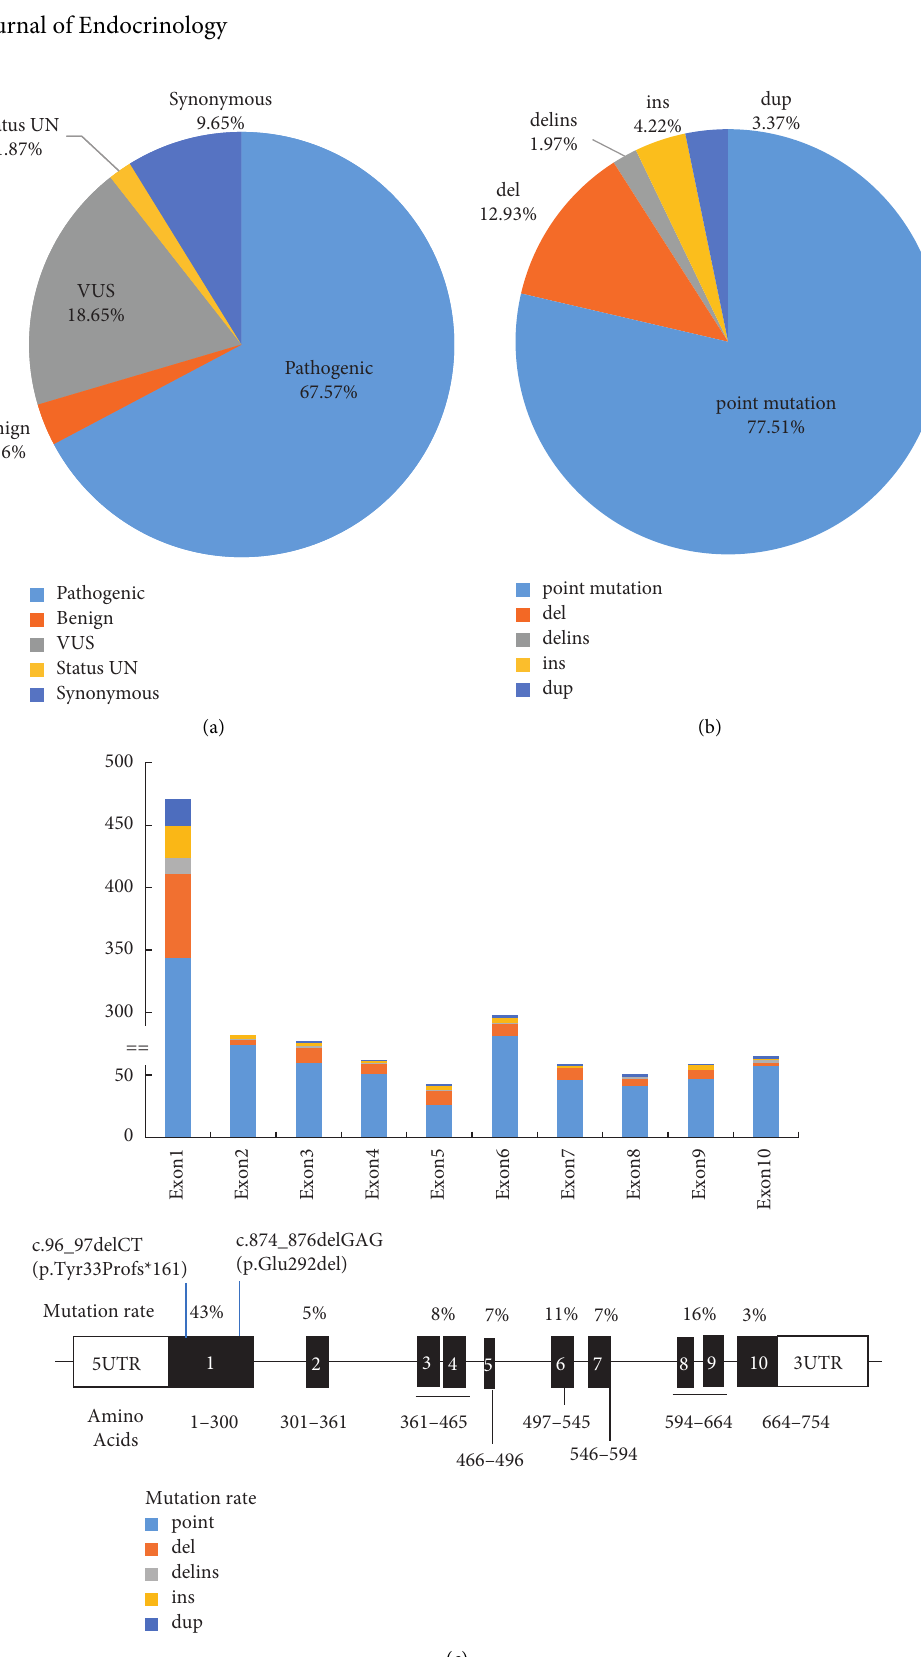
Figure 4: ABCD1 gene reported from the ALD mutation database. (a) Mutation sites types of variants of ABCD1 gene among reported nonrecurrent and other mutation sites, including pathogenic, synonymous, benign, variants of undetermined significance (VUS), and screening of newborns state of unknown (UN). (b) The content of ABCD1 mutations, including points mutations, deletion, del-insertion, insertion, and duplication (http://www.x-ald.nl/). (c) The distribution of mutations, including point mutation, deletion, del-insertion, insertion, and duplication. Most of the mutations harboring in exon 1. The lower panel shows the mutation rate in each exon. Bold shows the location of two novel mutations indicated in this